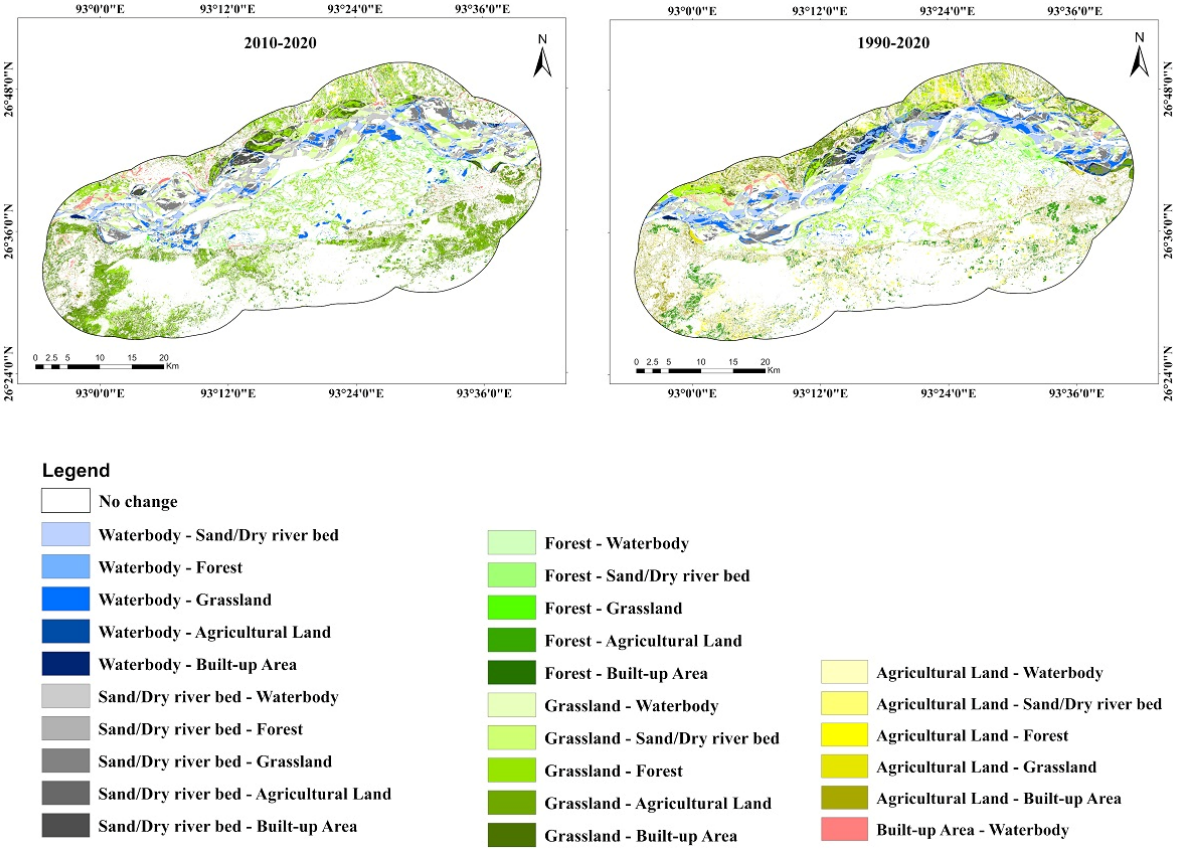
Figure 6. Change map of different LULC classes between 2000–2010 and 2010–2020.